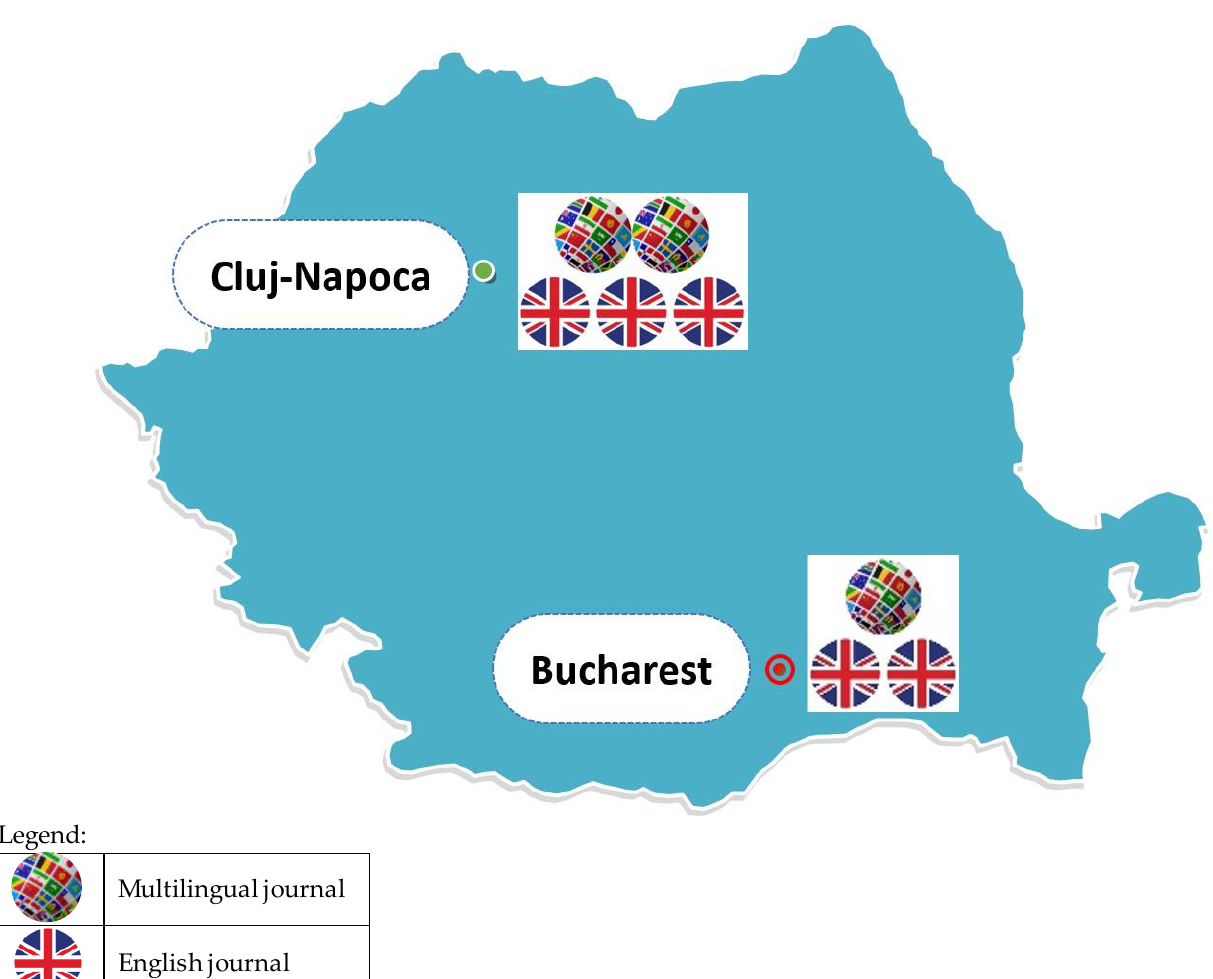
Figure 3. Bucharest vs. Cluj-Napoca, number of journals and language preferences.